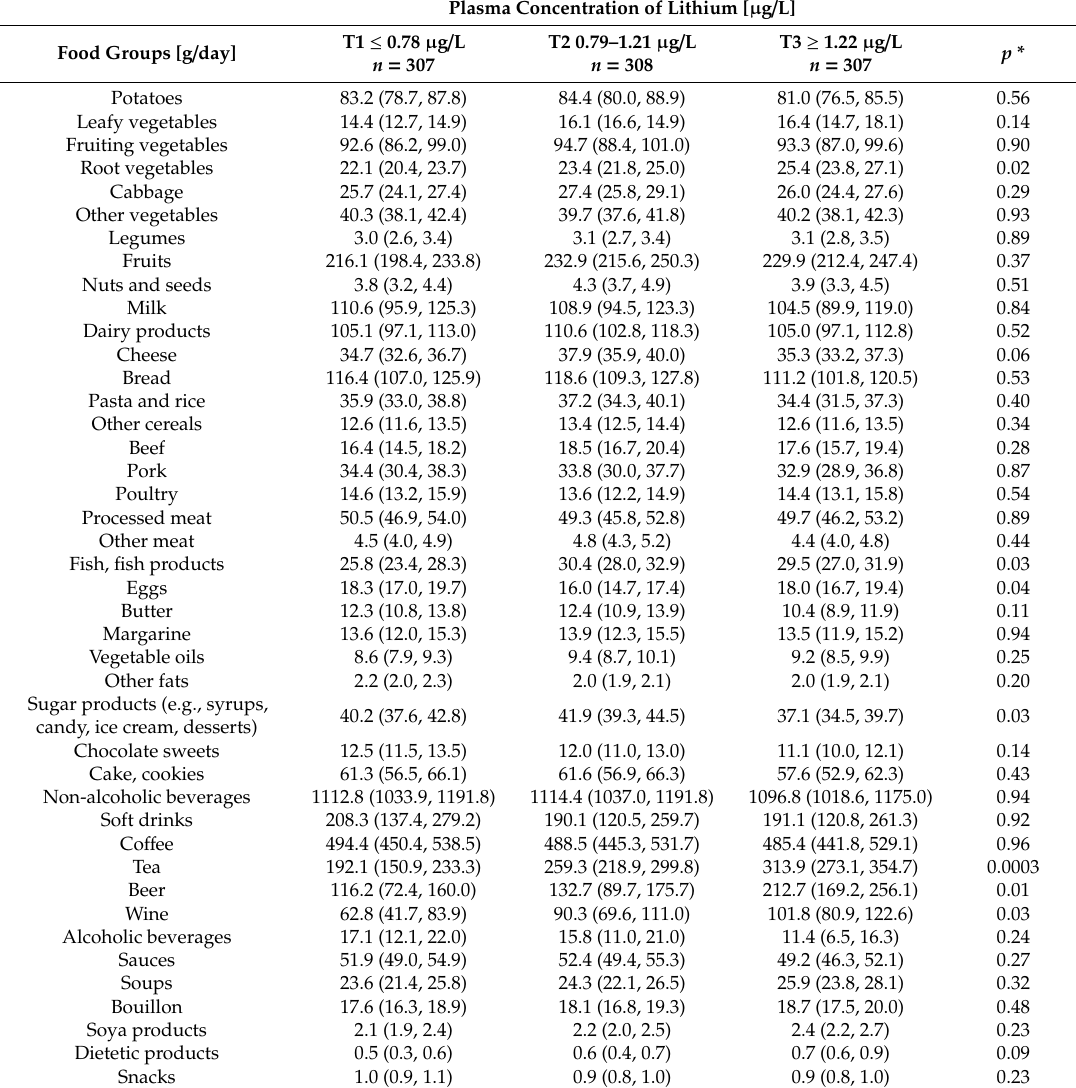
Table 4. Age- and sex-adjusted intake of 42 food groups [g / day] according to tertiles of plasma lithium concentrations ( n =